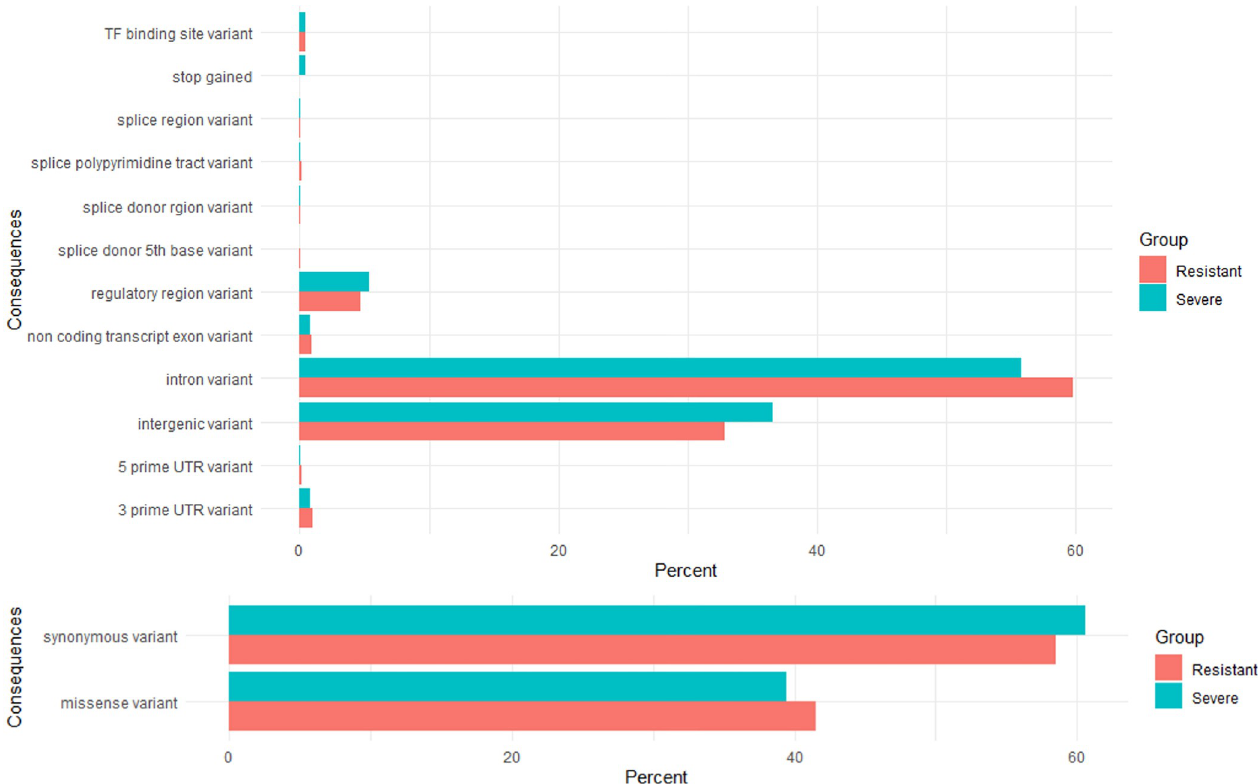
Fig 2. Distribution of significant SNPs for severe (upper panel) and resistant (lower panel) phenotypes, including their genomic annotation (left) and type of mutation for SNPs in coding regions (right).